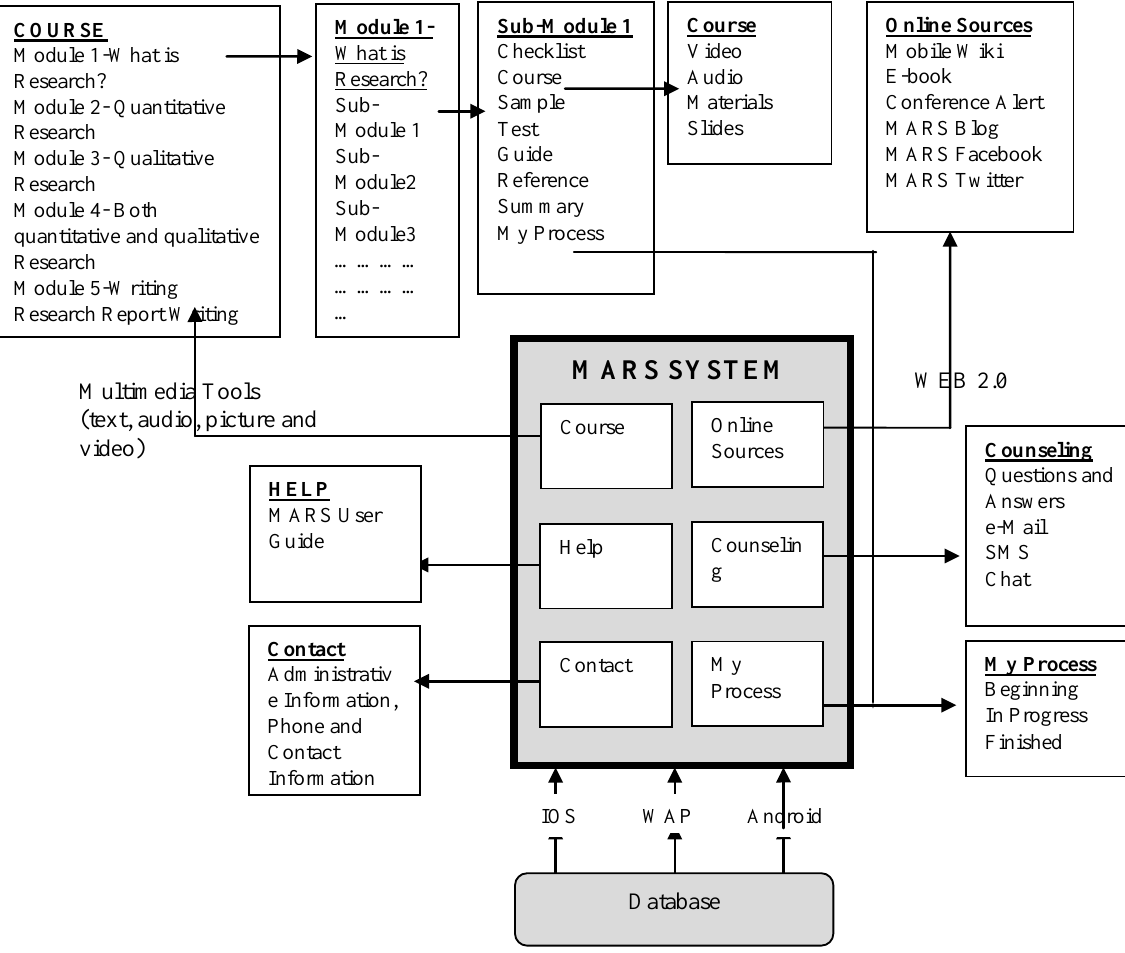
Figure 2 . Mobile academic research support protype model (Özdamar Keskin & Metcalf,